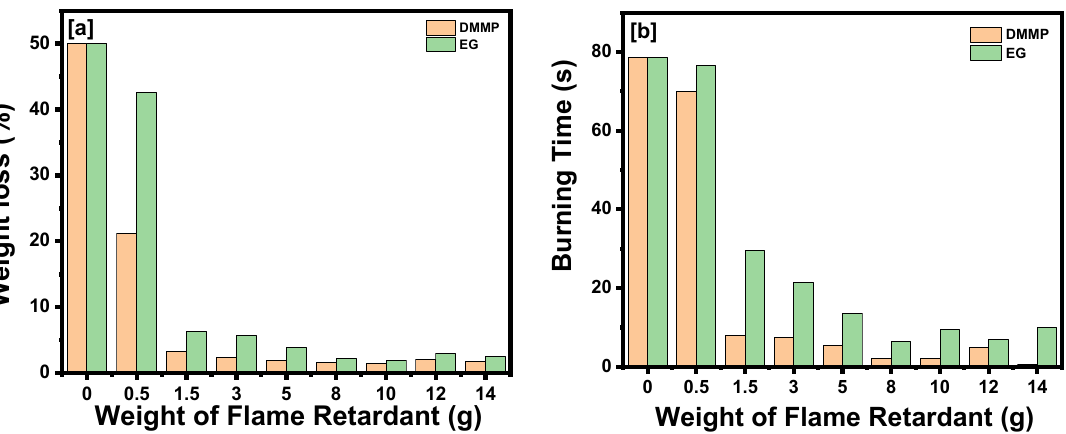
Figure 6. Graph showing the horizontal burning of the foams in terms of ( a ) weight loss (%) and ( b ) burning time (s) for the foams containing increasing amounts of DMMP and EG. The flame retardancy mechanism is an important analysis to elucidate the overall efficacy of FRs against fire. In that sense, there have been several studies in the literature that